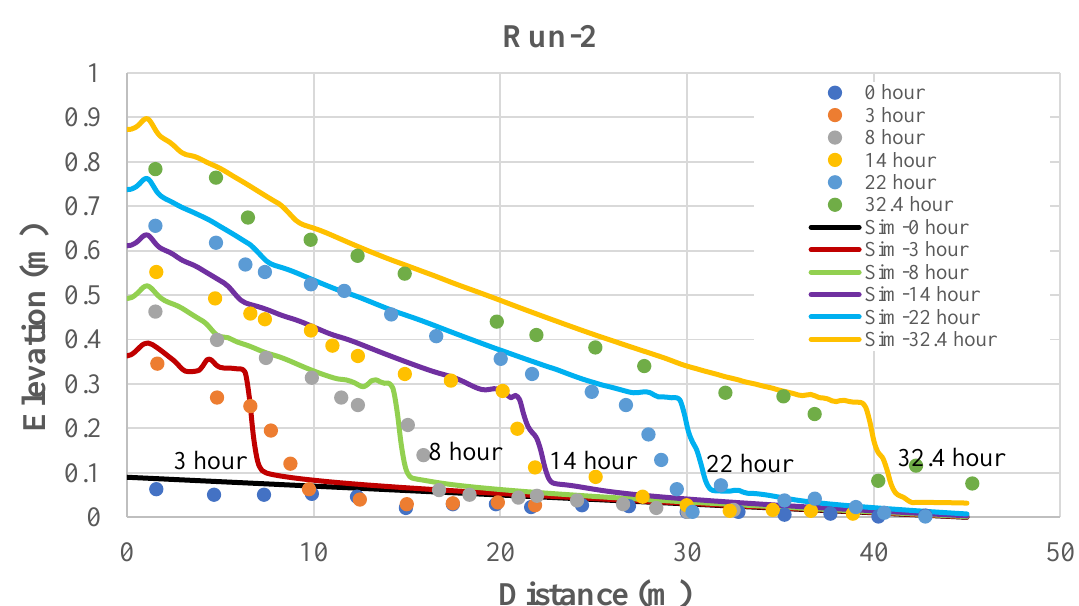
Figure 5. Longitudinal bed profiles at different times.